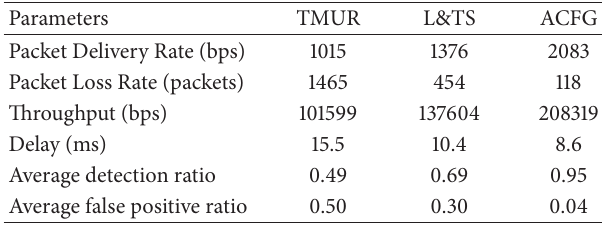
Table 2: Comparison of results.